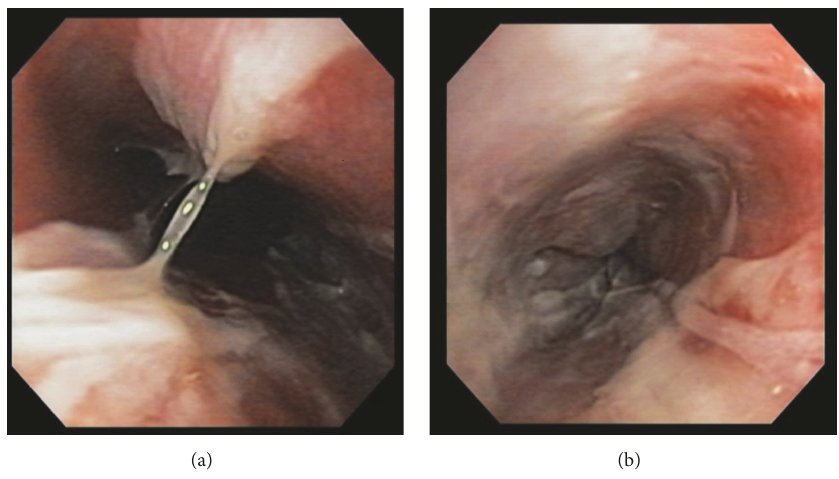
Figure 3: Erythema and desquamation of esophagus.